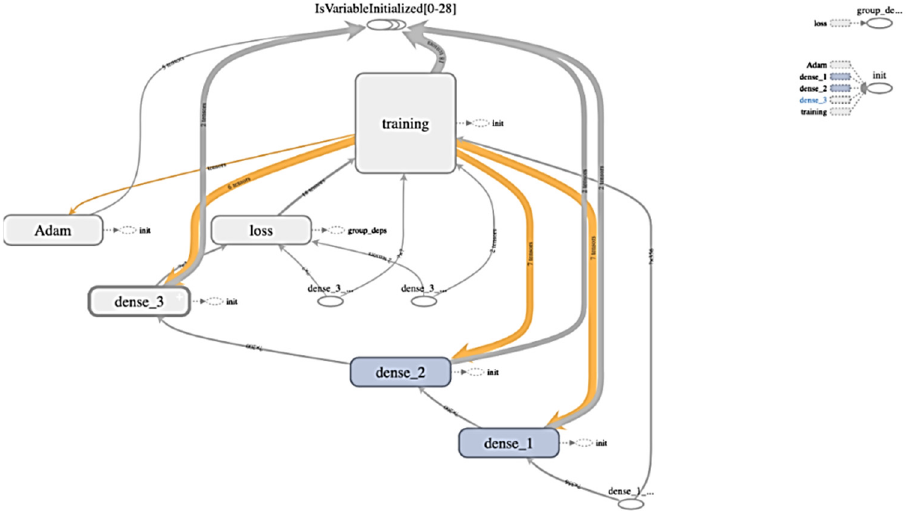
Figure 1. Structure of the neural network.